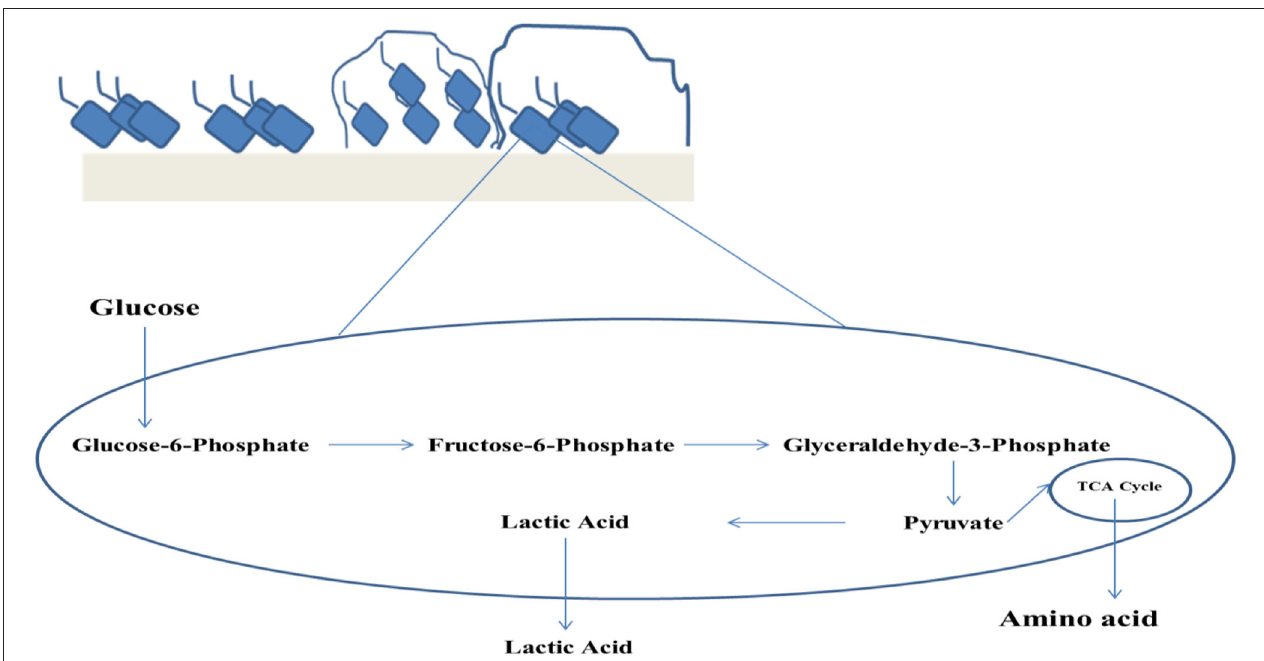
FIGURE 1 | Biofilm mediated lactic acid